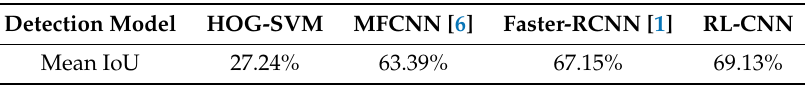
Table 4. Mean IoU of four detection models.